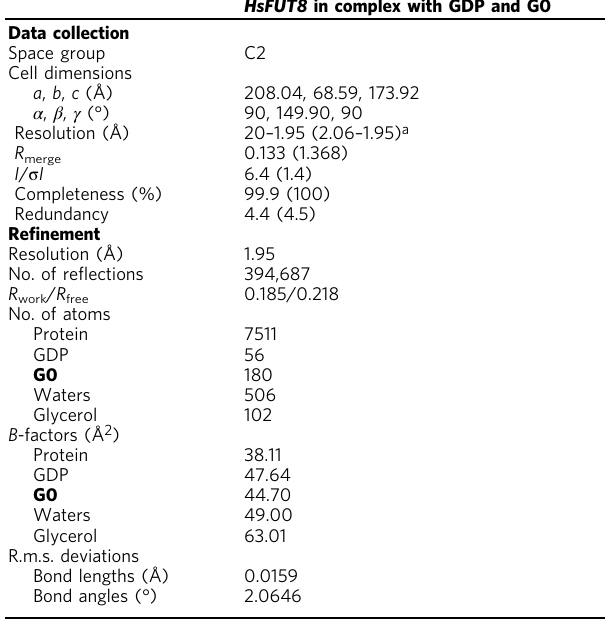
Table 1 Data collection and re fi nement statistics. HsFUT8 in complex with GDP and